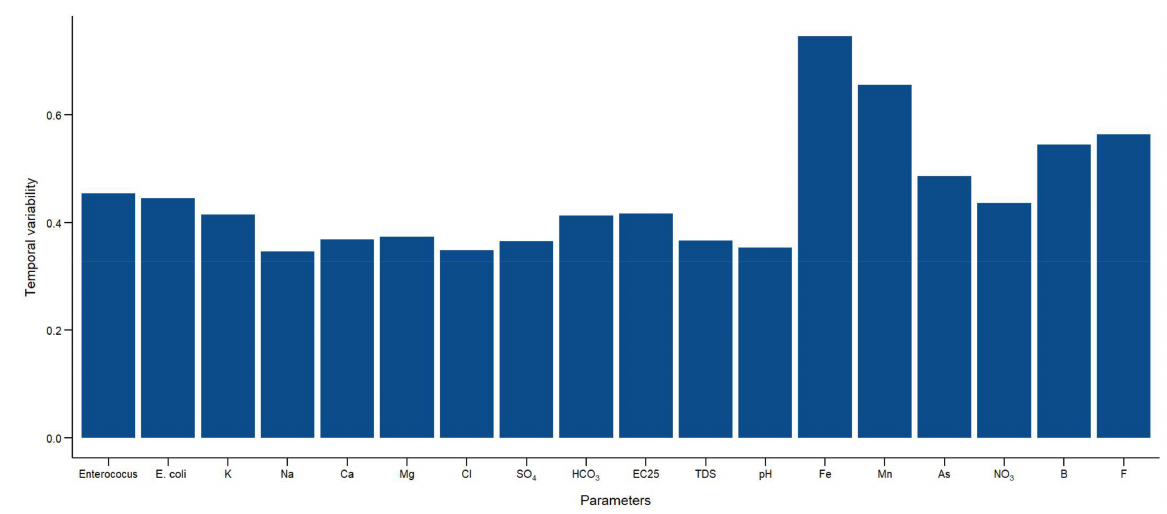
Figure 7. The rate of fraction of variance unexplained FVU within each parameter.